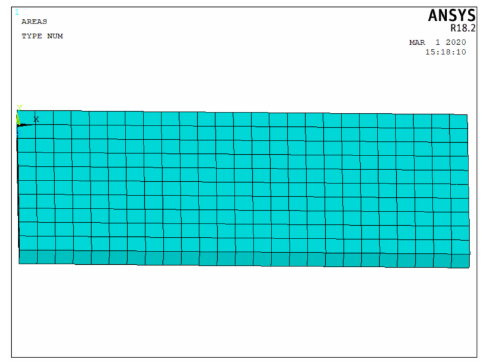
Figure 13. Finite element model of composite floor.